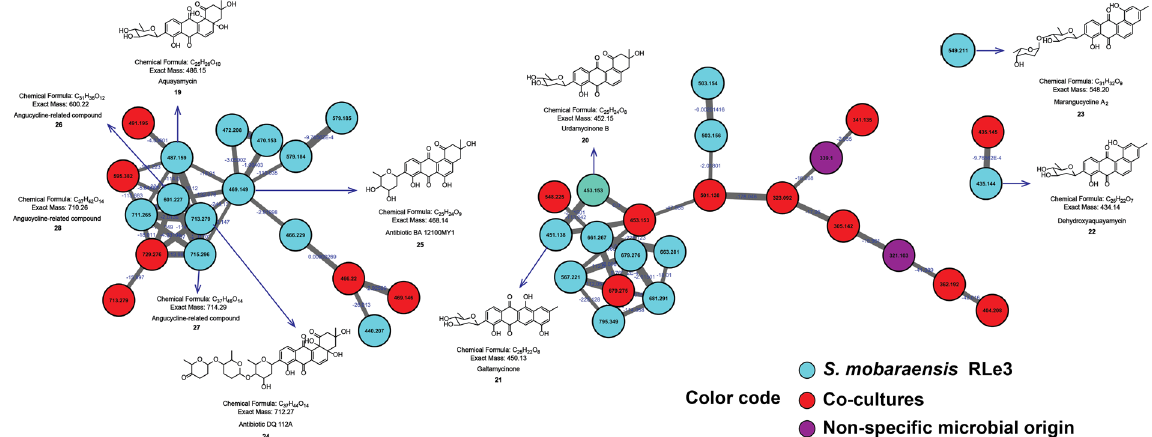
Figure 6. Angucyclines-clusters from molecular network of interactions among endophytic microorganisms from L . ericoides . Nodes from co-cultures are red and nodes from mono- and co-cultures of S . mobaraensis RLe3 are in